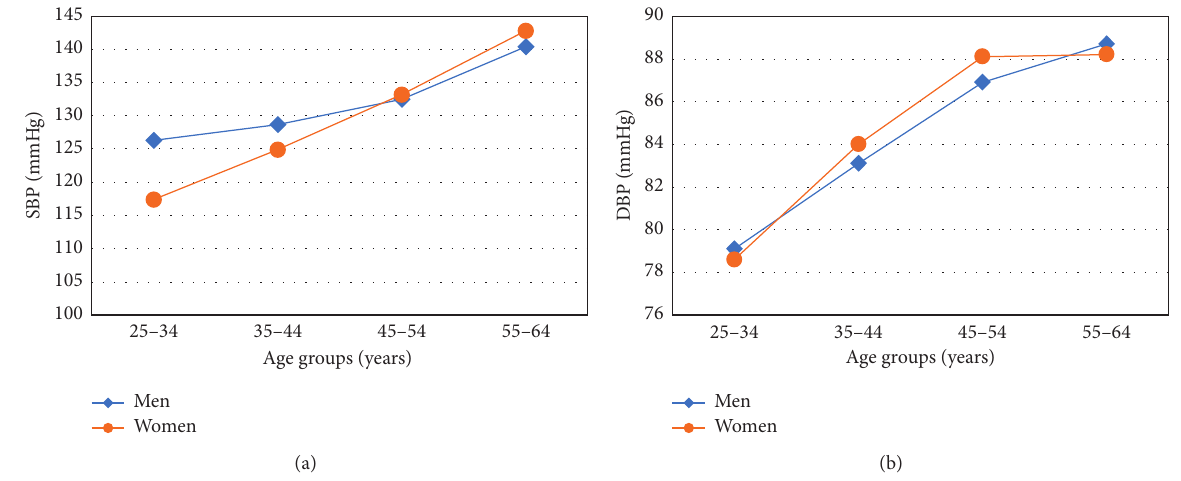
Figure 1: Trend of systolic and diastolic blood pressure by age and sex.